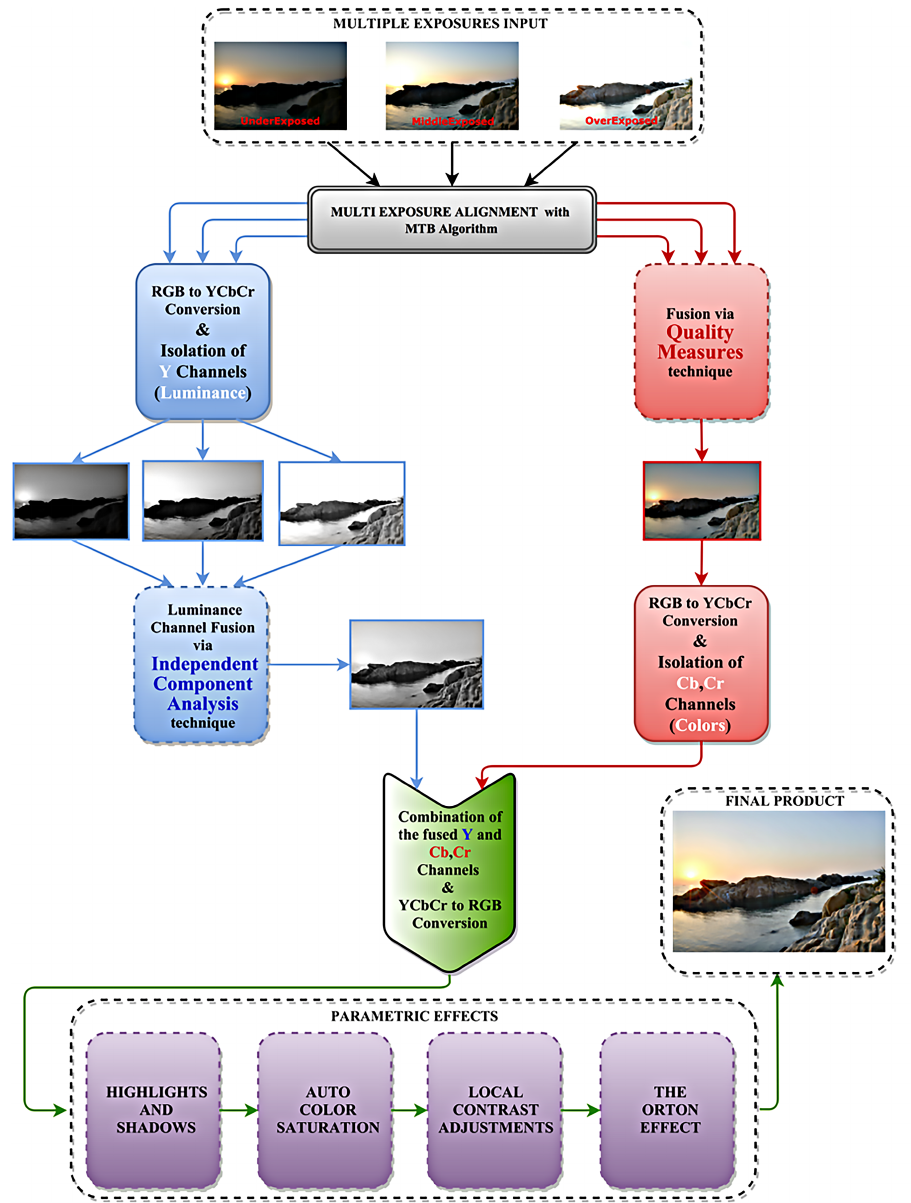
Figure 1. The proposed Exposure Fusion